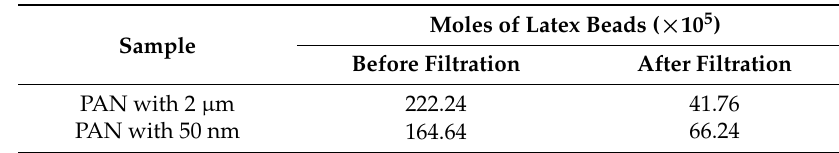
Table 2. Particulate filtration efficacy of PAN membranes with latex beads.